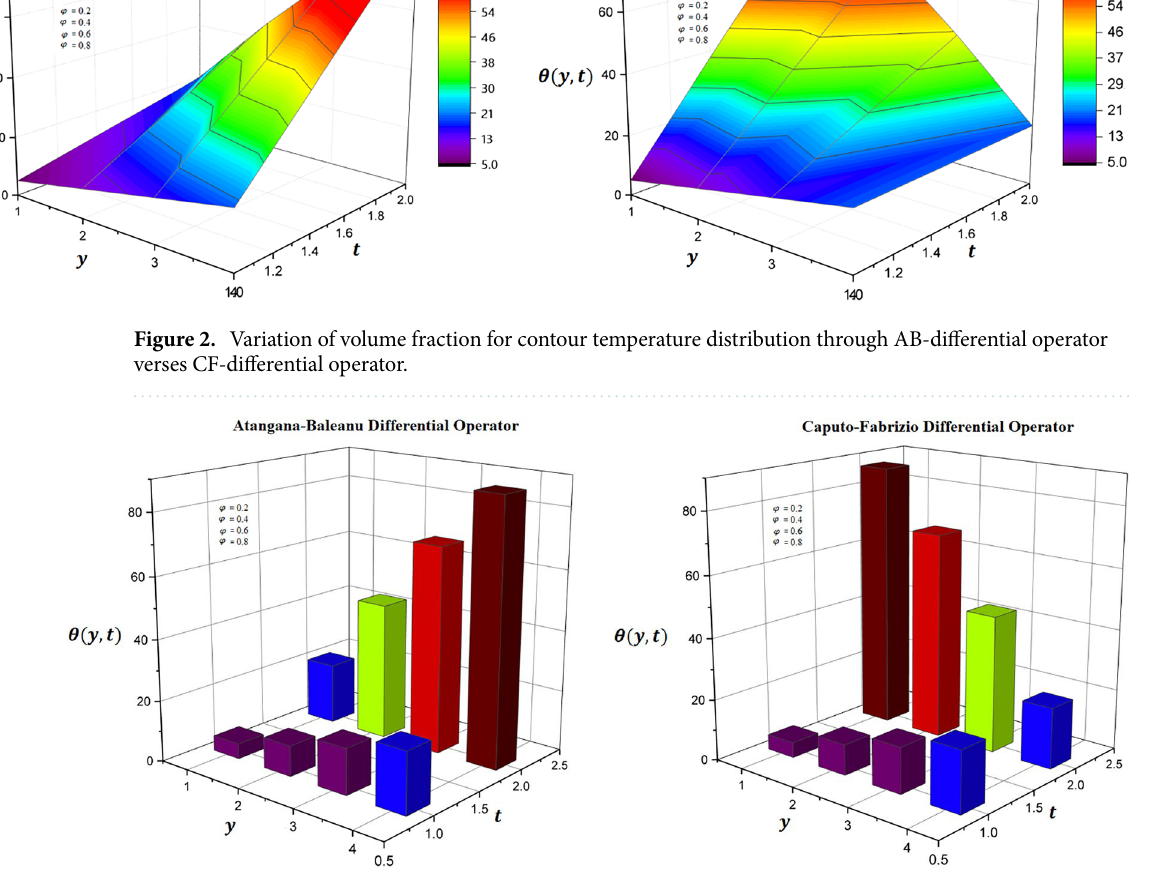
Figure 3. Variation of volume fraction for three-dimensional temperature distribution through AB-differential operator verses CF-differential operator.